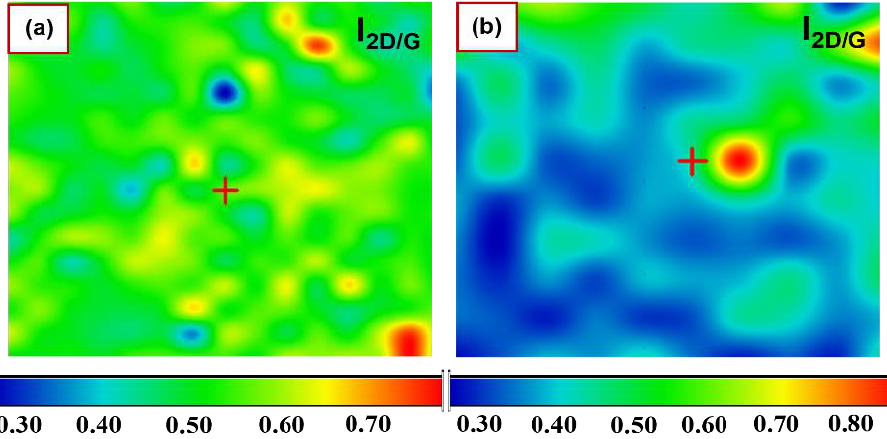
Figure 3. Raman mapping of graphene on SiC substrate: ( a , b ) represent the mapping image of the 2D/G intensity ratio for few-layer and multilayer samples, respectively.